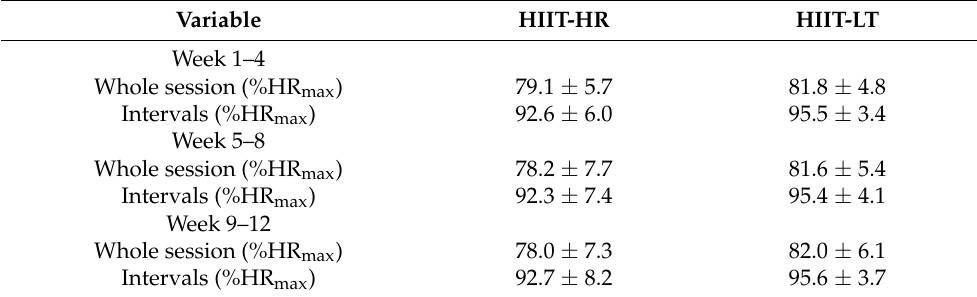
Table 1. Average heart rate during intervals and during the whole exercise session 1 .